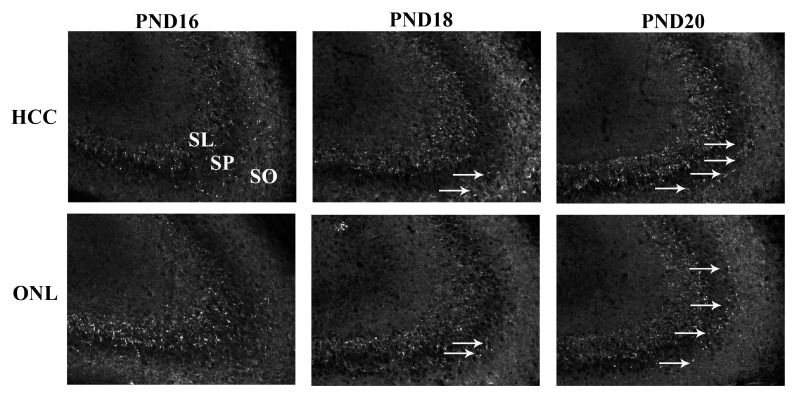
Synaptophysin staining in the CA3 region as an indicator of mossy fiber (MF) projections.Brains from PND16, PND18 and PND20 from home cage control (HCC) and object in a novel location (ONL) groups were removed and processed immunohistochemically for synaptophysin staining in the CA3 region as a marker for MF connectivity. Top panel shows representative staining from the three age groups from the HCC condition and bottom panel show staining from the ONL condition. Abbreviations: SO: stratum oriens; SP: stratum pyramisale; SL: stratum lucidum. Arrows point to synaptophysin-positive puncta in the SO region.